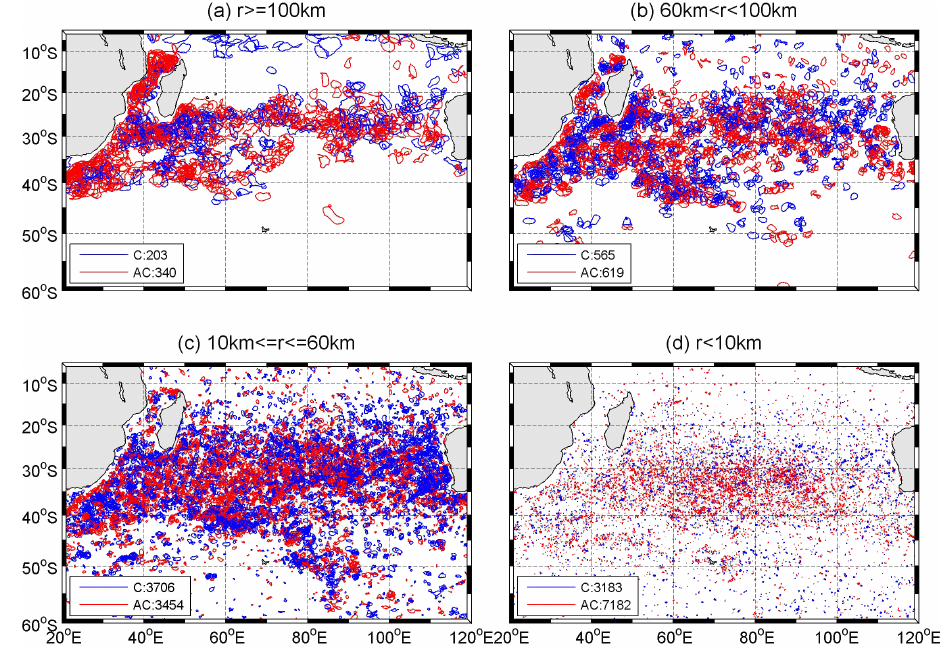
Figure 9. The distribution of cyclonic and anticyclonic eddies detected from drifters in the